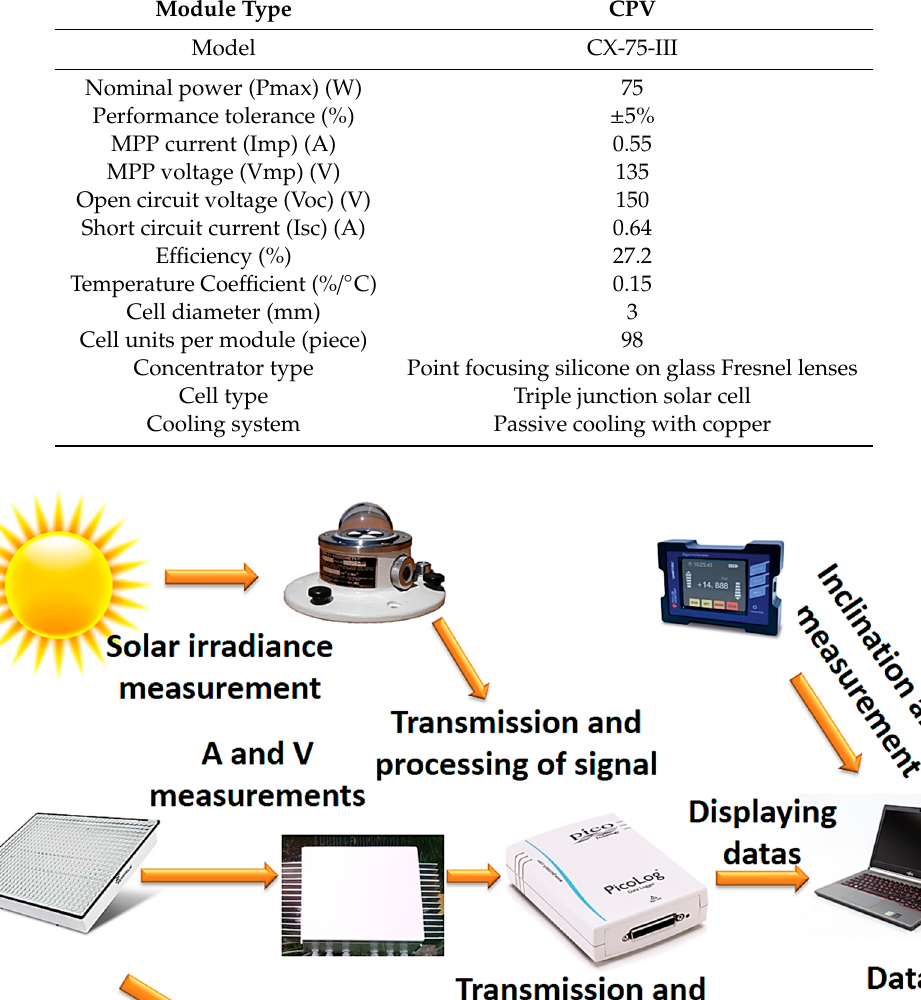
Figure 5. The configuration of PV module measuring station ‘B’.